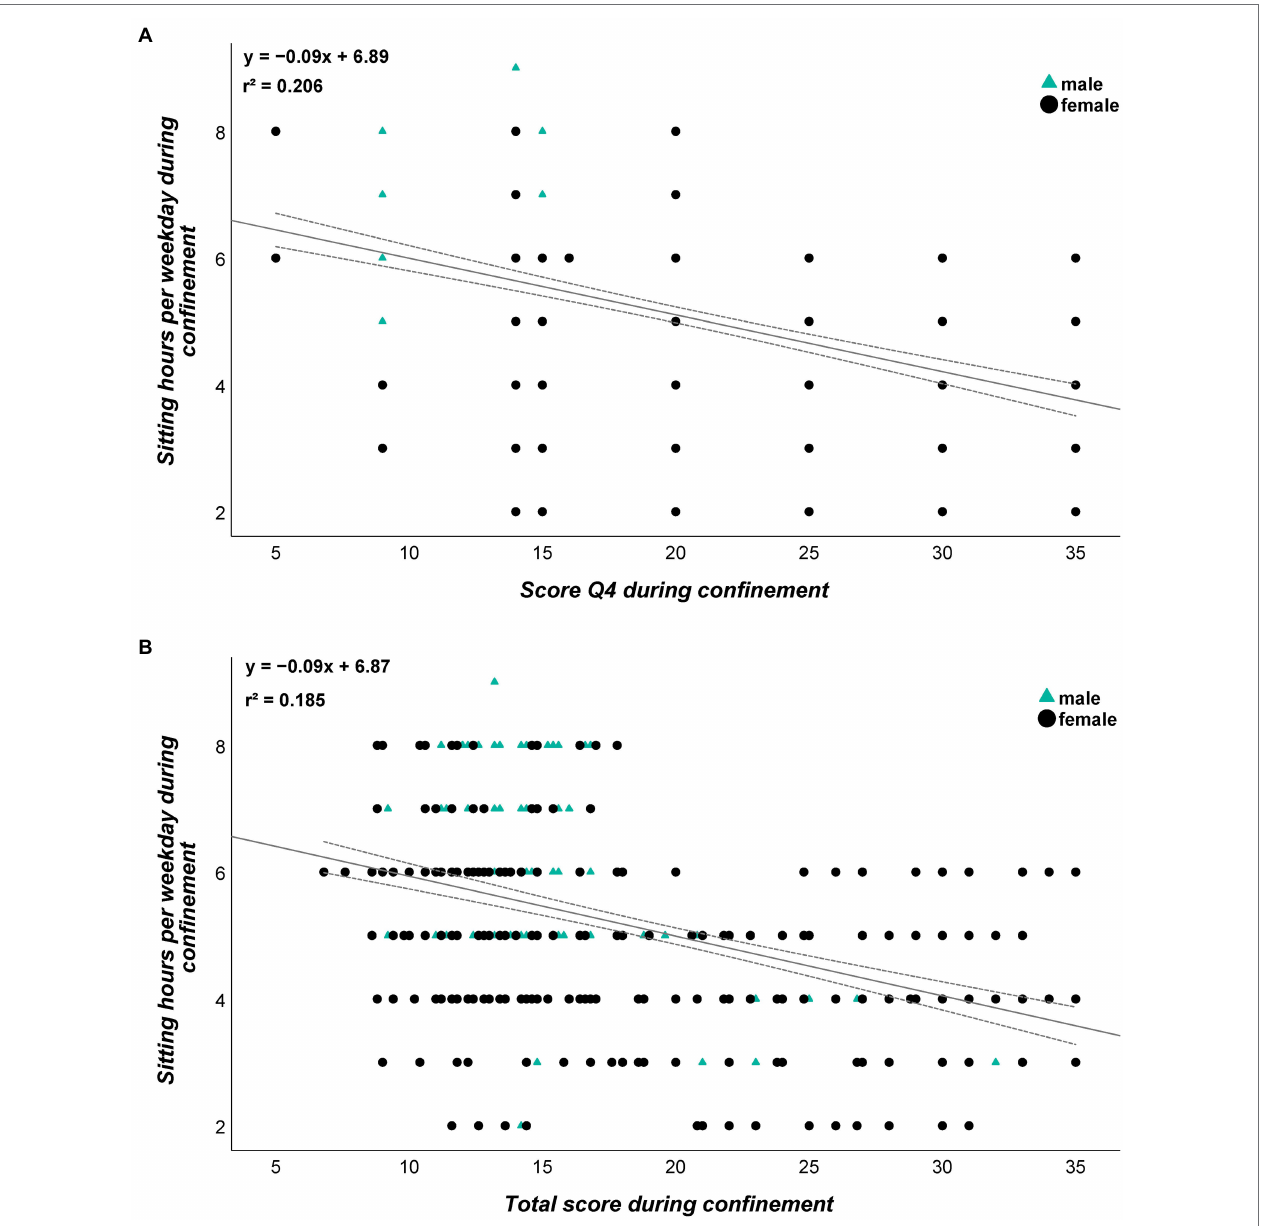
FIGURE 4 | Relationship between sitting time and Q4 (A) and sitting time and total score (B) depending on gender. Please note that one dot can represent several